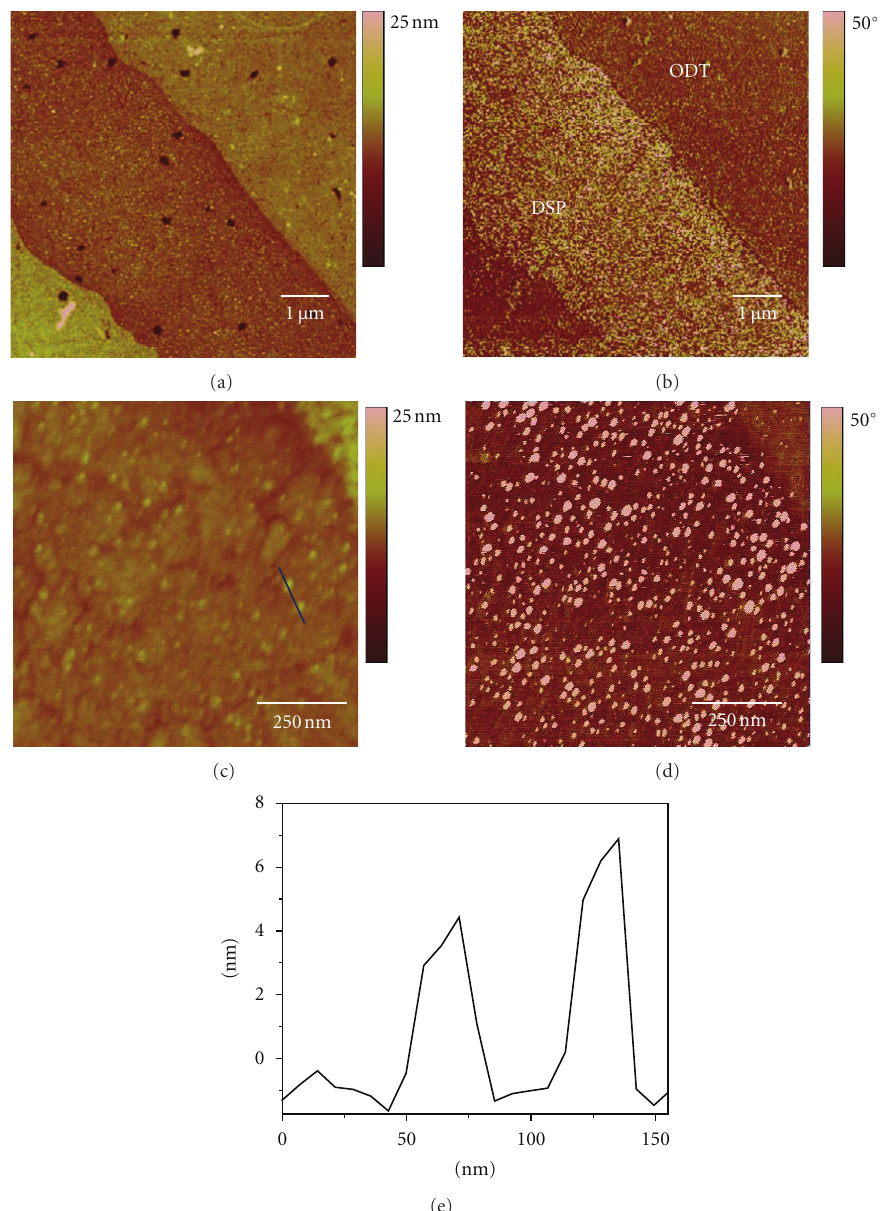
Figure 4: SPM image of capture surface patterning: (a) height and (b) phase (8 × 8 μ m), zoomed in analysis; (c) height and (b) phase of capture stripe (avidin immobilized on DSP) containing bound G4 biotinylated PAMAM dendrimers. Cross-section analysis of bound G4 biotinylated PAMAM dendrimers in (d) is shown in (e). The capture platform was exposed to 200 μ L of 5.0 μ mol/L concentration of G4 biotinylated PAMAM dendrimer